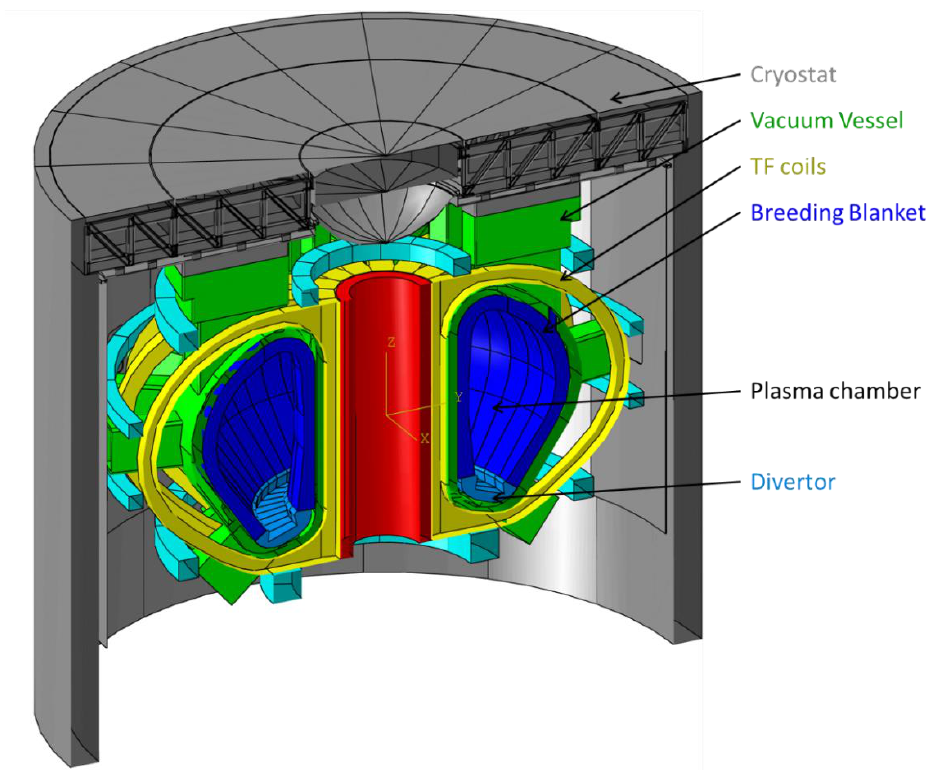
Figure 1. The European demonstration fusion power reactor (EU DEMO) tokamak (Reproduced from [1], EUROfusion Consortium: 2020.).